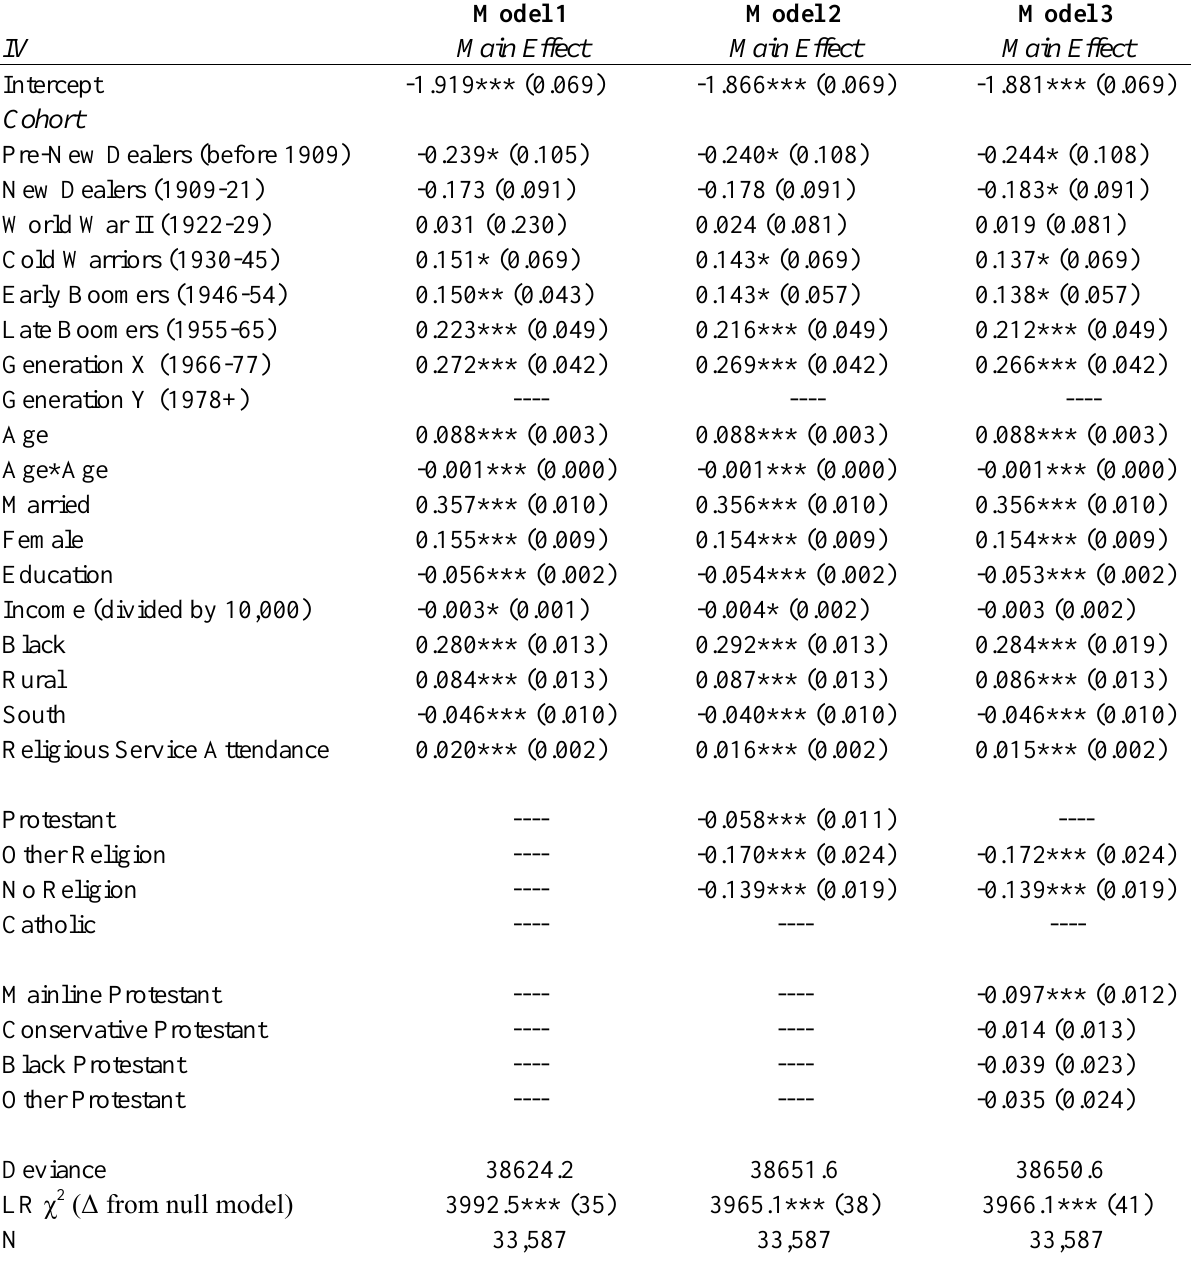
Table 2. Results of Three Negative Binomial Models Predicting Self-Reported